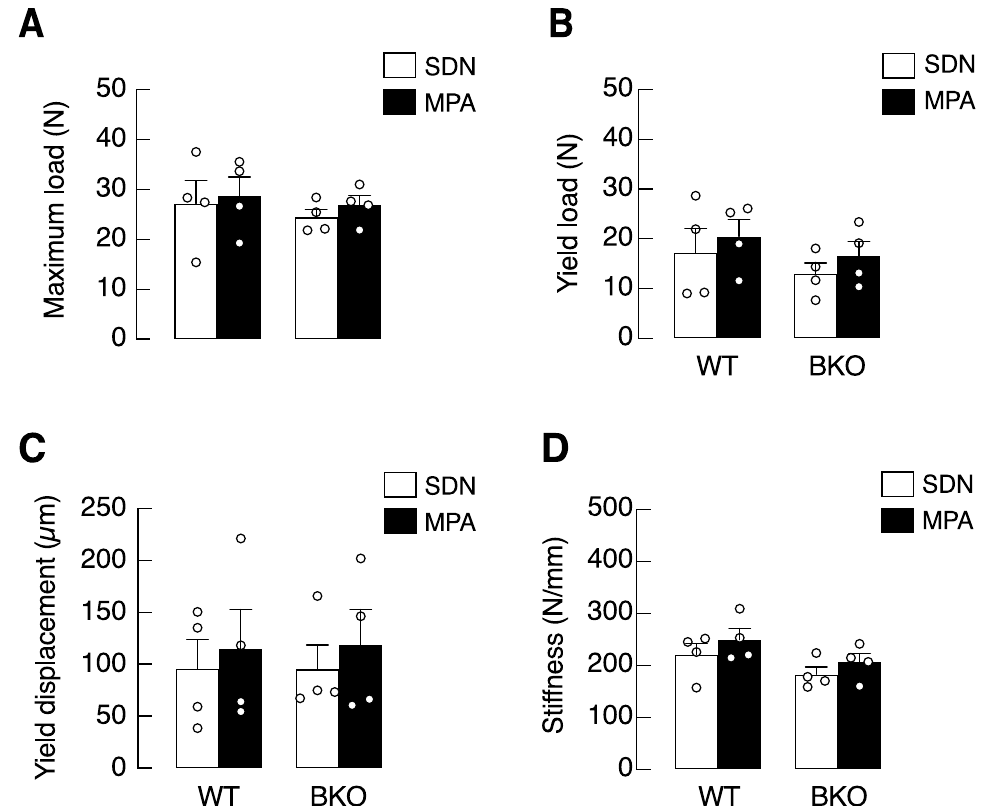
Figure 6. Mechanical properties of left femora of β-globin knockout (BKO) and wild-type (WT) mice after mild-intensity physical activity (MPA) training compared with the sedentary (SDN) control, i.e., ( A ) maximum load, ( B ) yield load, ( C ) yield displacement, and ( D ) stiffness. Values are means ± SE (n =